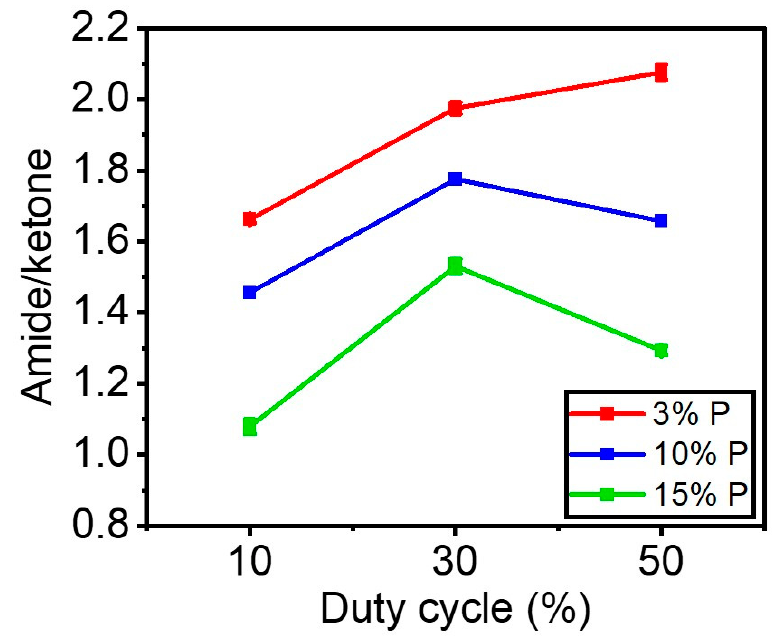
Figure 11. The amide/ketone ratios using the curve fitting under the region (1500–1800 cm − 1 ) in FTIR spectra as a function of the duty cycle and amount of precursor.